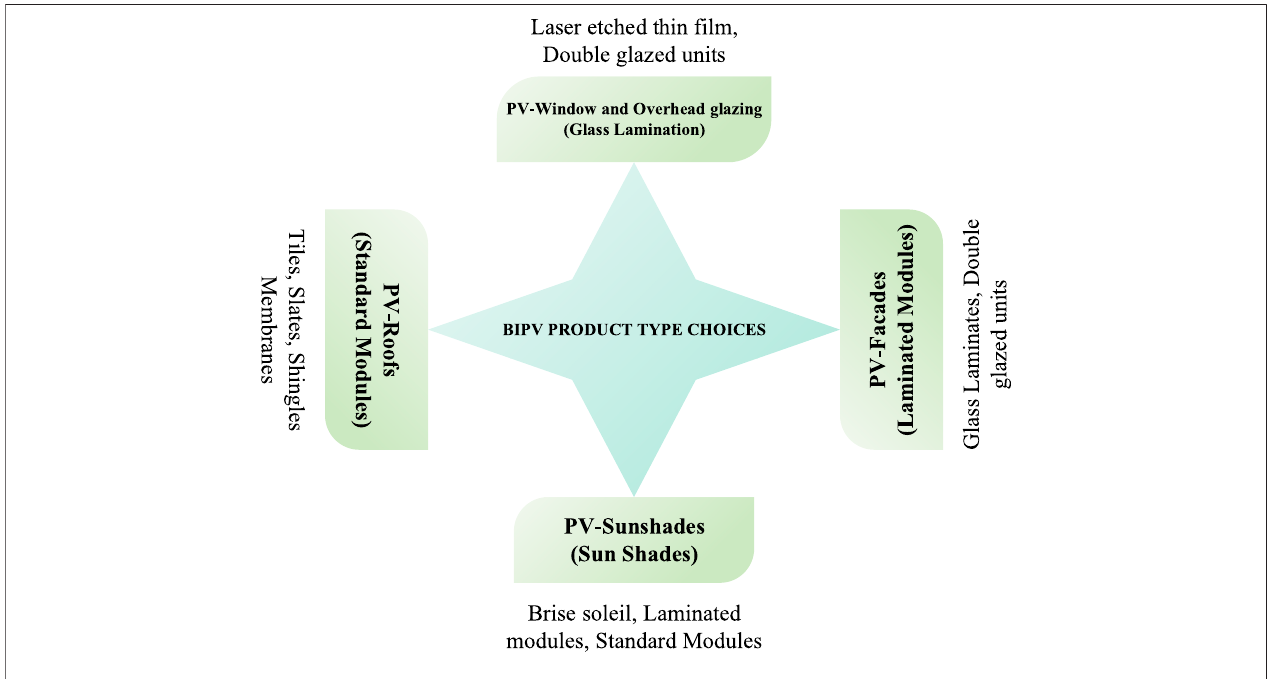
FIGURE 12 | Types of BIPV product type choices.